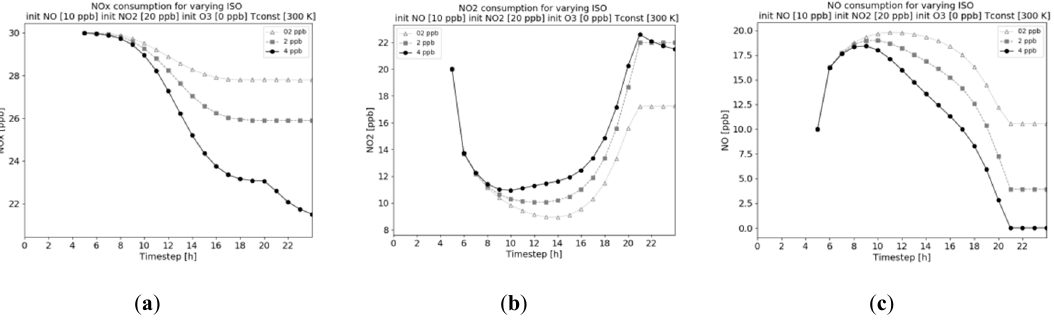
Figure 7. The 24 h simulated concentration for ( a ) NO x , ( b ) NO 2 , and ( c ) NO for varying initial isoprene concentrations.